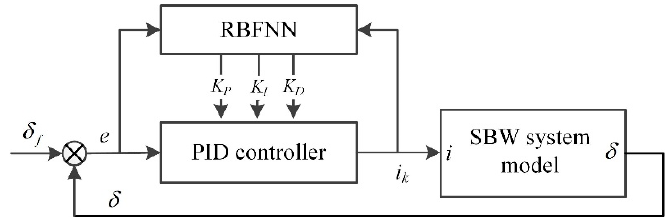
Figure 5. The architecture of the RBFNN-PID controller.